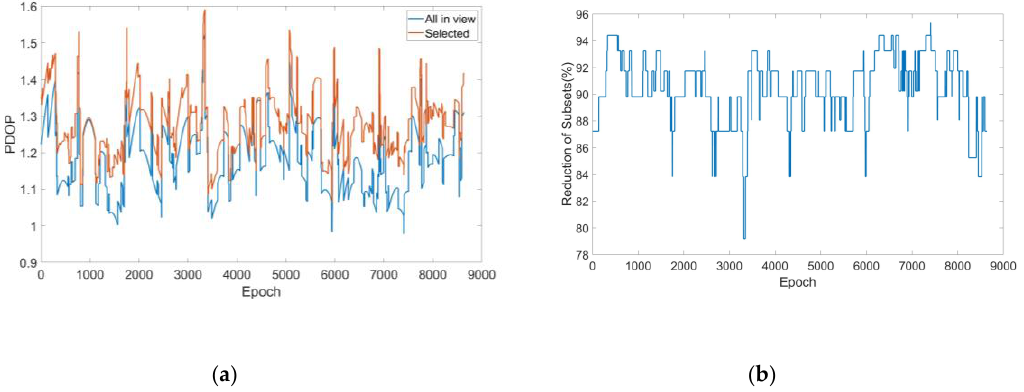
Figure 7. ( a ) Comparison of the position dilution of precision (PDOP); ( b ) reduction of subsets after